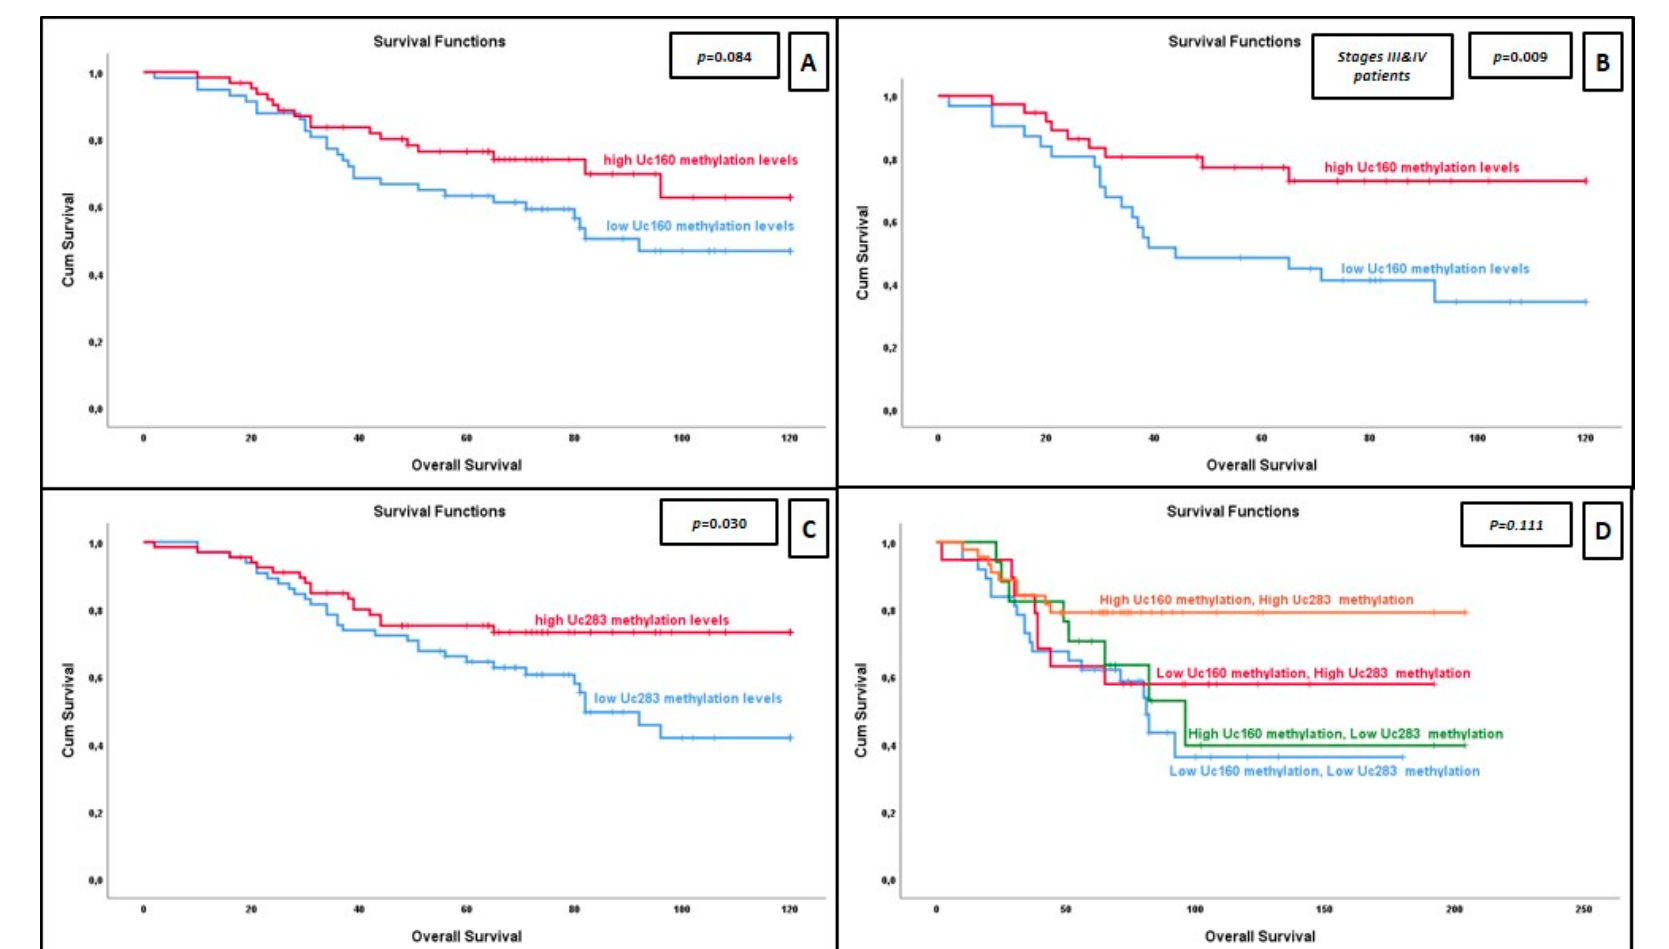
Figure 5. Kaplan–Meier curves for overall survival with regard to relative methylation levels of ( A ) Uc160 for all patients, ( B ) Uc160 for stages III and IV patients, ( C ) Uc283 and ( D ) Uc160 and Uc283 combination (high and low methylation levels determined by median values).